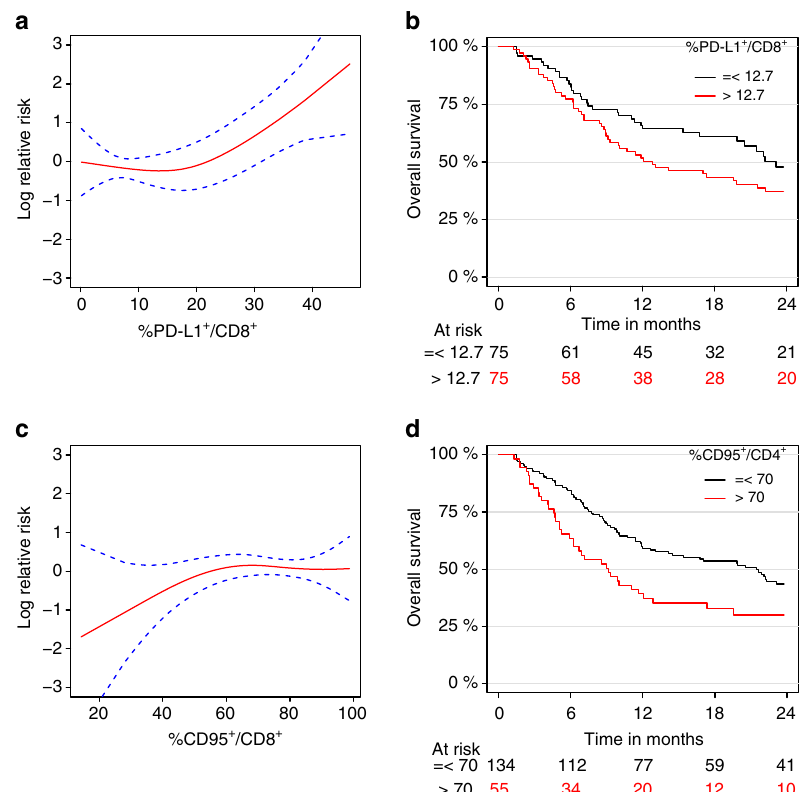
Fig. 6 Relative risk of death according to PD-L1 or CD95 on T cells. Overall survival is ful fi lled for n = 189 patients including 121 events. a Graphical visualization of the log relative risk according to the expression of PD-L1 on CD8 + T cells ( p = 0.011 in the multivariate analysis, Supplementary Table 5). The dashed blue lines represent the 95% con fi dence intervals. b Kaplan − Meier OS curves segregating the whole cohort according to the median value (i.e., 12.7%) for the PD-L1 expression on blood CD8 + T cells at baseline. c Graphical visualization of the log relative risk according to the expression of CD95 on CD8 + T cells ( p = 0.33 in the multivariate analysis, Supplementary Table 5). The dashed blue lines represent the 95% con fi dence intervals. d Kaplan − Meier OS curves segregating the whole cohort according to a cutoff value of 70% for the CD95 expression on blood CD4 + T cells at